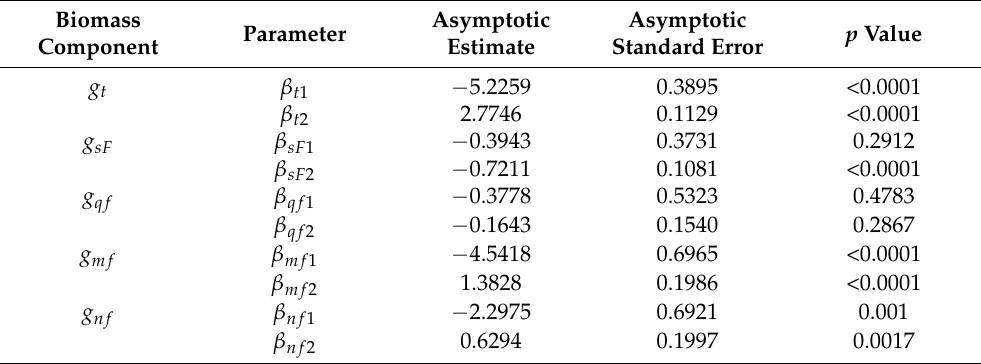
Table 4. Parameter estimates and their asymptotic standard error and p values for the Dis-ML biomass equation system. Asymptotic Biomass Parameter Estimate Component